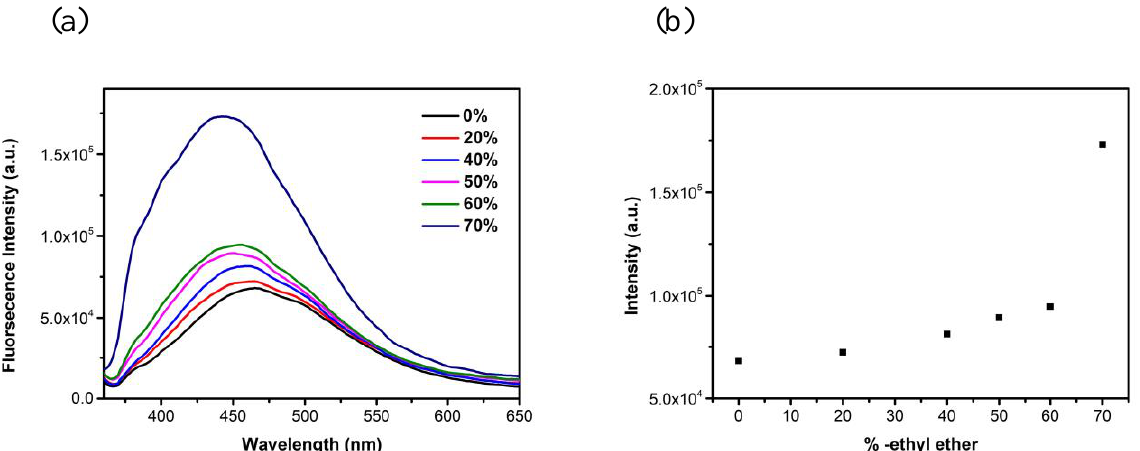
Figure 6. ( a ) Fluorescence emission spectra of Cage-1 in the varying proportions of acetone–ethyl ether solvent mixture; ( b ) Fluorescence intensity of Cage-1 at 340 nm in the varying proportions of acetone–ethyl ether solvent mixture (c = 1.0 × 10 − 6 M, λ ex = 340 nm, Slit = 2, 2).